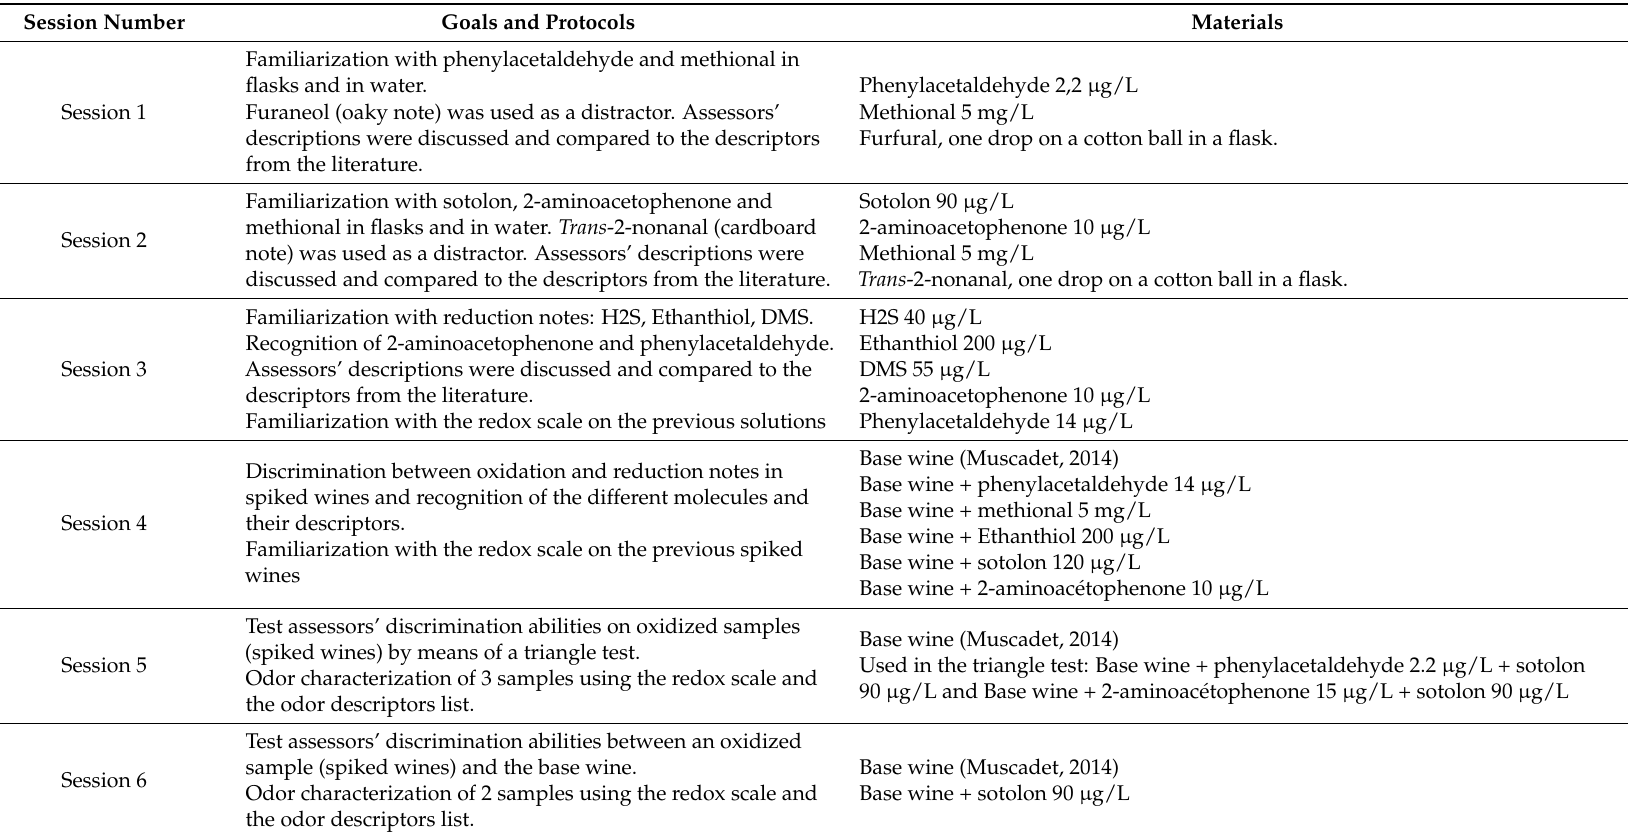
Table 2. Summary of the training and selection sessions prior to sensory